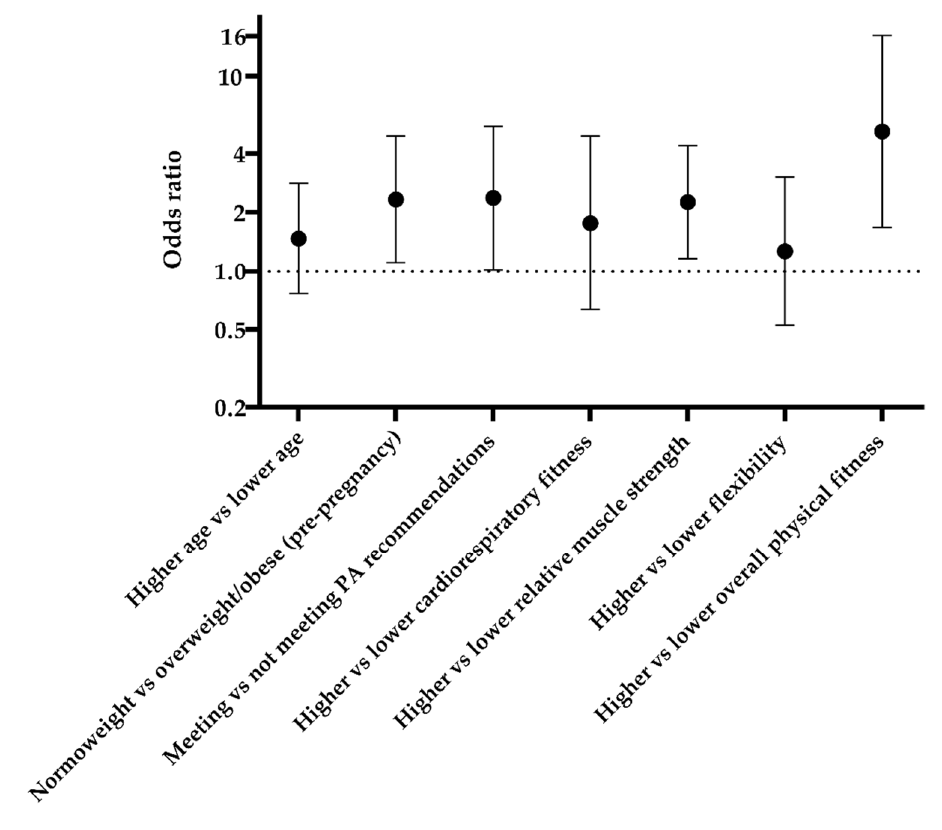
Figure 1. Determinants of adherence to the Mediterranean diet. PA—physical activity. The linear regression analysis assessing the association of dietary habits with indi- vidual PF components and overall PF is shown in Supplementary Table S3. A greater consumption of whole-grain cereals ( p = 0.012), fruits ( p = 0.003), and fish ( p = 0.031) were associated with greater CRF. A higher intake of red meat and subproducts was associated with lower CRF ( p = 0.032). Regarding relative muscle strength, a higher intake of poultry was associated with lower relative muscle strength ( p = 0.014). No associations were found between dietary habits and flexibility (all, p > 0.05). In addition, a higher intake of fruits ( p = 0.015) and vegetables ( p = 0.004) and a lower intake of poultry ( p = 0.041) were associated with greater overall